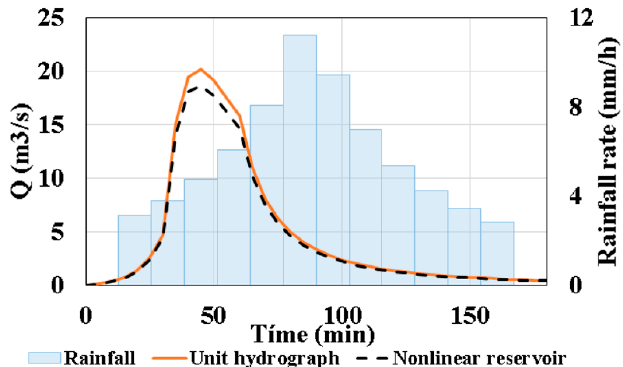
Figure 6. Comparison between the unit hydrograph and the nonlinear reservoir methods for the case study. Table 1. Green-Ampt parameters values used [48,55].